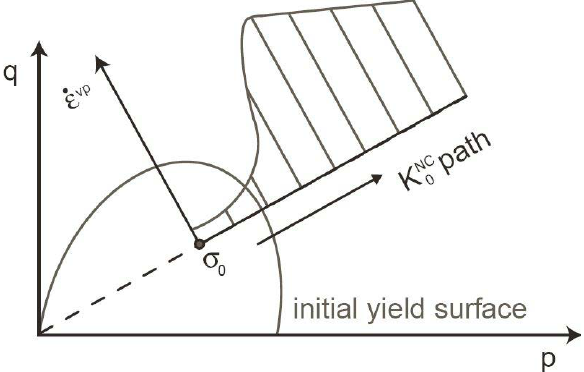
Figure 1: Influence of OCR on the creep rate in oedometric conditions.